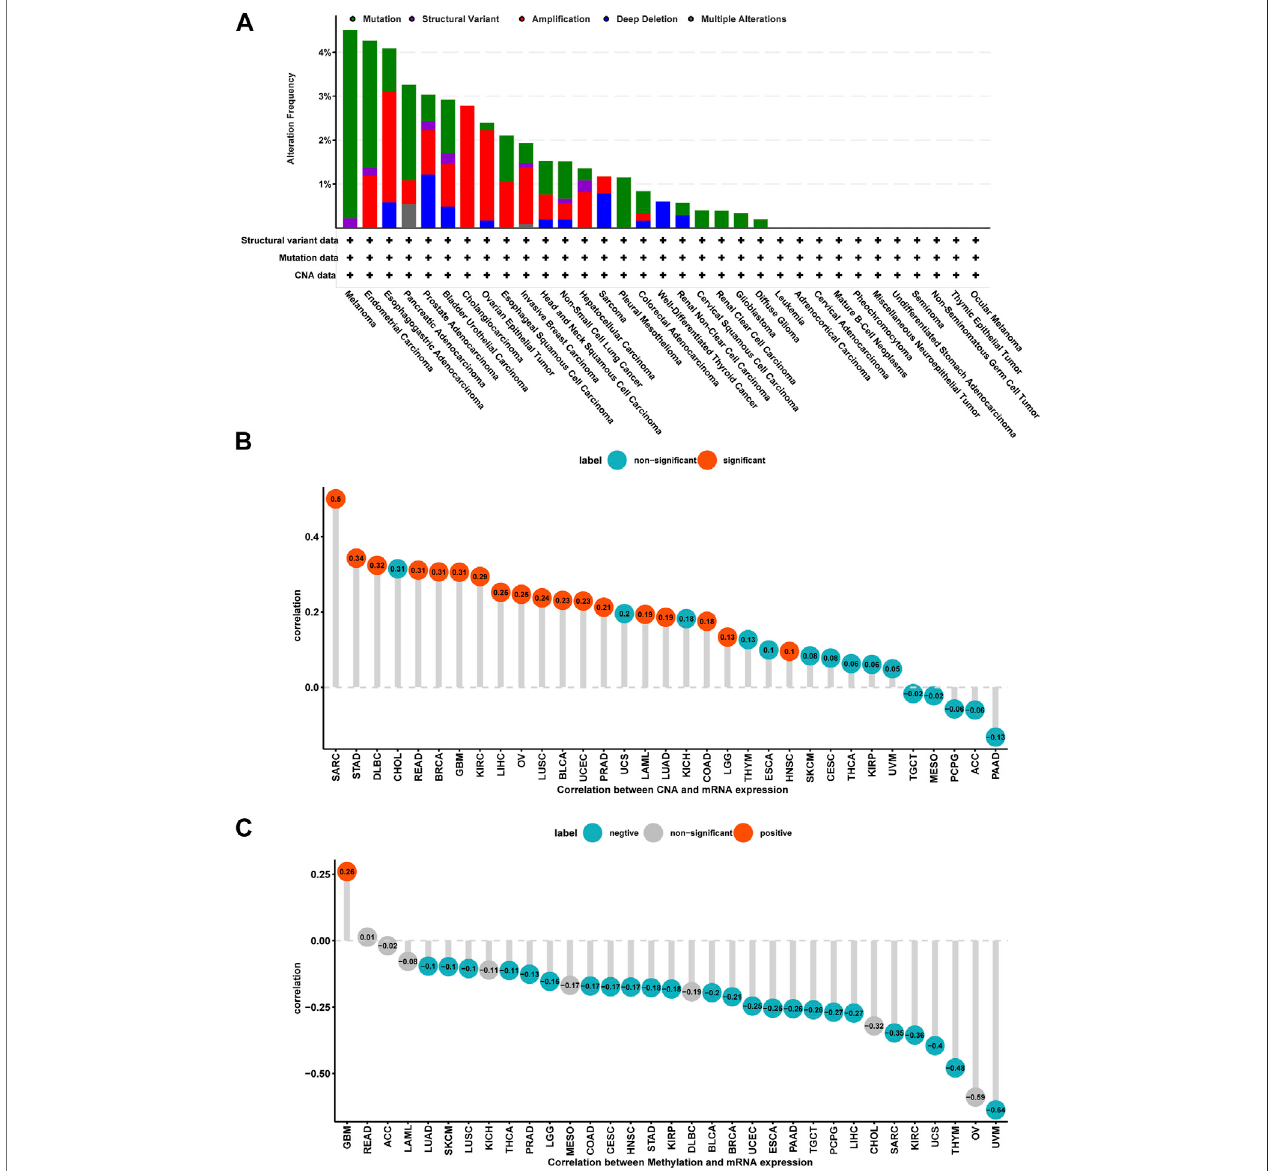
FIGURE3| GenealterationofP4HA1. (A) ThemutationandCNAstatusofP4HA1inTCGA-pan-cancer. (B) ThecorrelationbetweenP4HA1expressionandCNA. (C) The correlation between P4HA1 expression and DNA methylation.